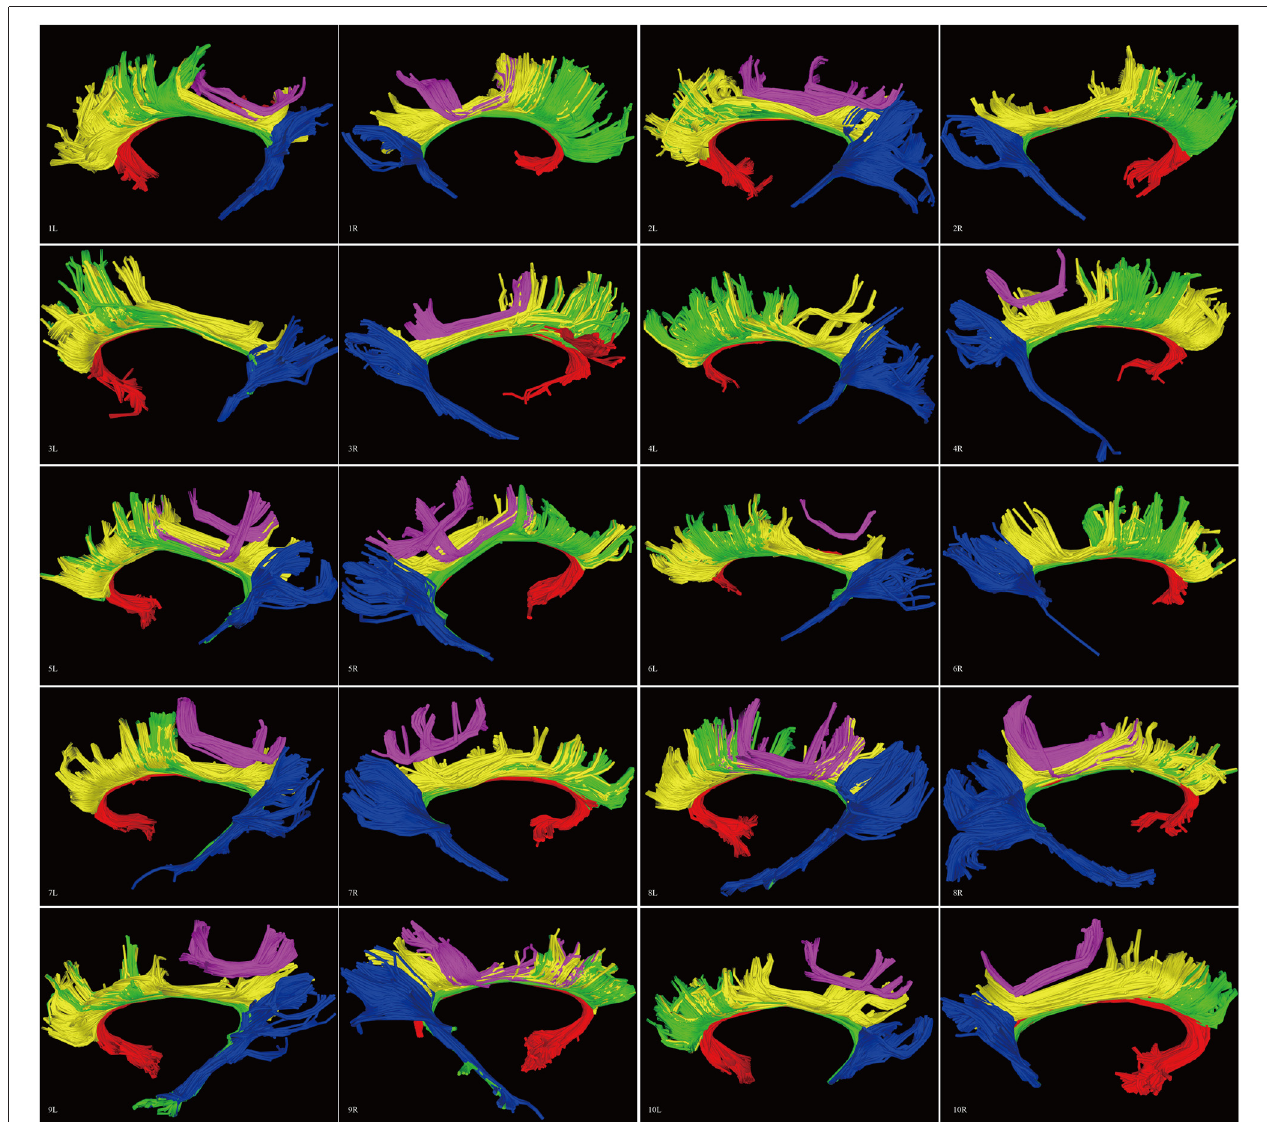
FIGURE 8 | Diffusion spectrum imaging (DSI) tractography of the CB in 20 hemispheres of 10 subjects on sagittal view. Order: subject 1, 2, 3, 4, 5, 6, 7, 8, 9, 10. Left and right CB had a similar location, shape and trajectory in all 20 hemispheres. The CB-IV can be delineated in 16 out of 20 hemispheres. On further analysis of all subjects, the CB-IV is parallel and adjacent to the others in 7 out of 16 hemispheres. In the remaining nine hemispheres, the CB-IV is located above the others in a sup-CB pattern. Red color, CB-I; green color, CB-II; yellow color, CB-III; purple color, CB-IV; blue color, CB-V; L, left; R,